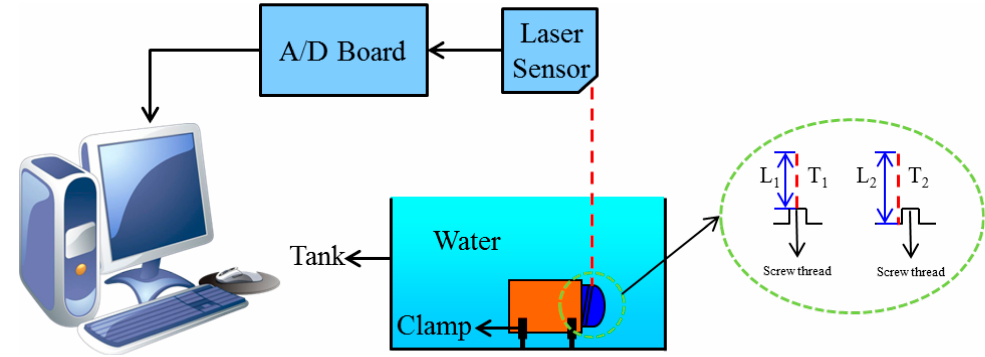
Figure 10. Schematic diagram for measuring the rotational speed.